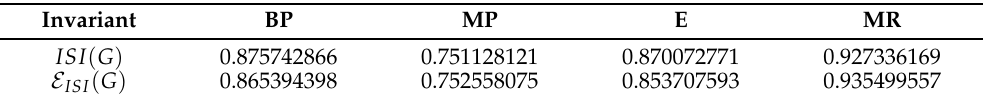
Table 2. Correlation Coefficients of Anticancer Drugs with the ISI -Index (Energy) of their Chemical